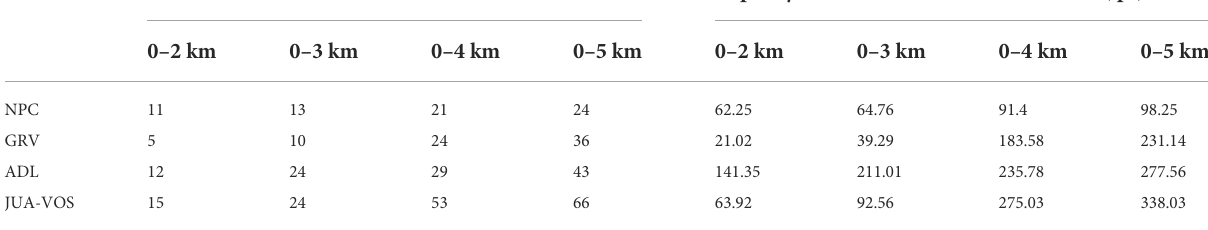
TABLE 2 Post-2004 number and capacity of wells for each buffer zone (cumulative) as of August 2019.